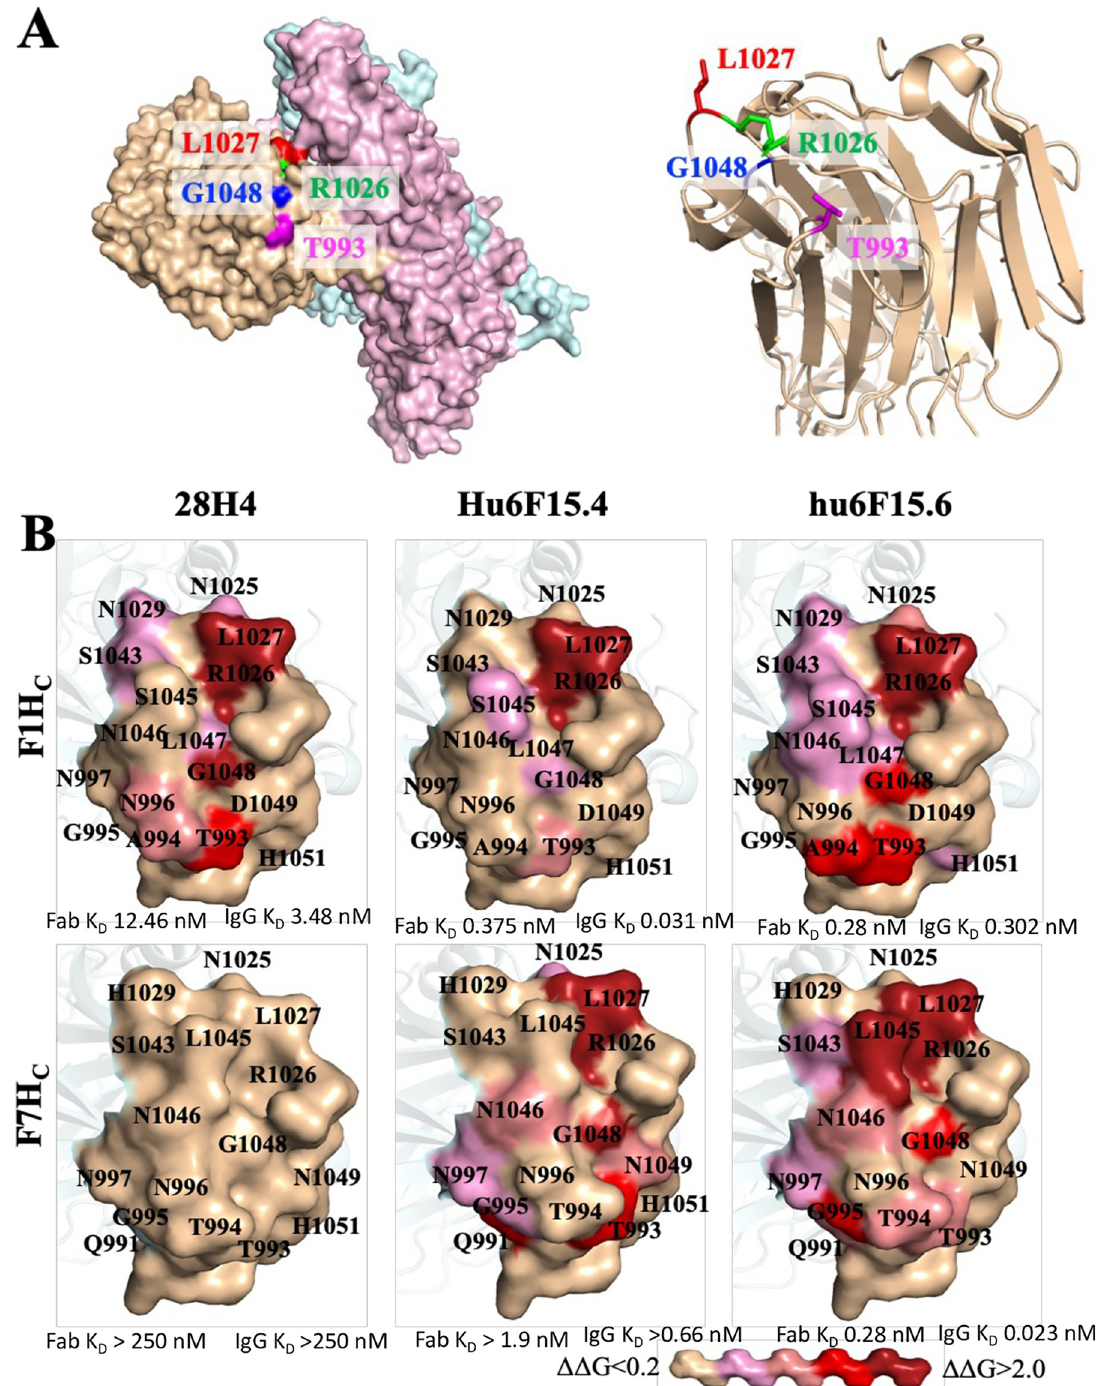
Fig 6. The epitopes of 28H4, hu6F15.4 and hu6F15.6 on BoNT/F1 and BoNT/F7. A. The key amino acid residues in the epitope of 28H4, hu6F15.4 and hu6F15.6. In the left panel, four key residues for the binding of 28H4 to BoNT/F1 (T993, R1026, L1027 and G1048) are shown on a surface model of the BoNT/F1 holotoxin (Alphafold, AF-A7GBG3). The BoNT/F1 H C is shown in beige, the catalytic domain (LC) in blue, and the translocation domain in pink. In the right panel, the side chains of the same four key residues are shown on a ribbon diagram of the crystal structure of BoNT/F1 H C (pdb, 3fuq). The four key amino acid residues are located on three different loops B. The fine epitope maps of mAbs 28H4. The contribution of amino acid side chains in mAb binding was measured and shown by coloring the surface side chain projection on either the BoNT/F1H C structure (pdb, 3fuq) or a model of the BoNT/F7H